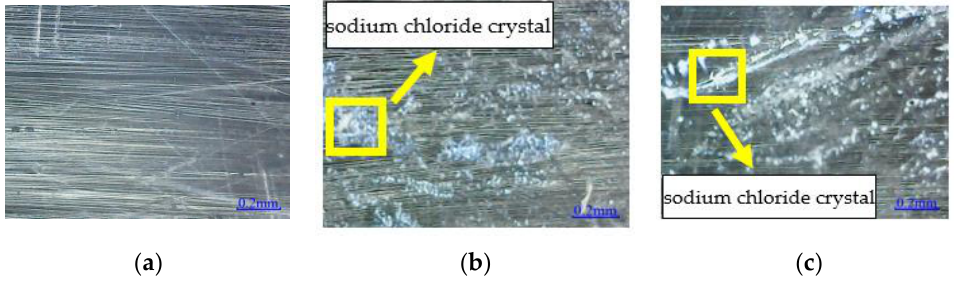
Figure 13. Microstructure: ( a ) CFRPND; ( b ) CFRPSI-400; and ( c ) CFRPSF-100.